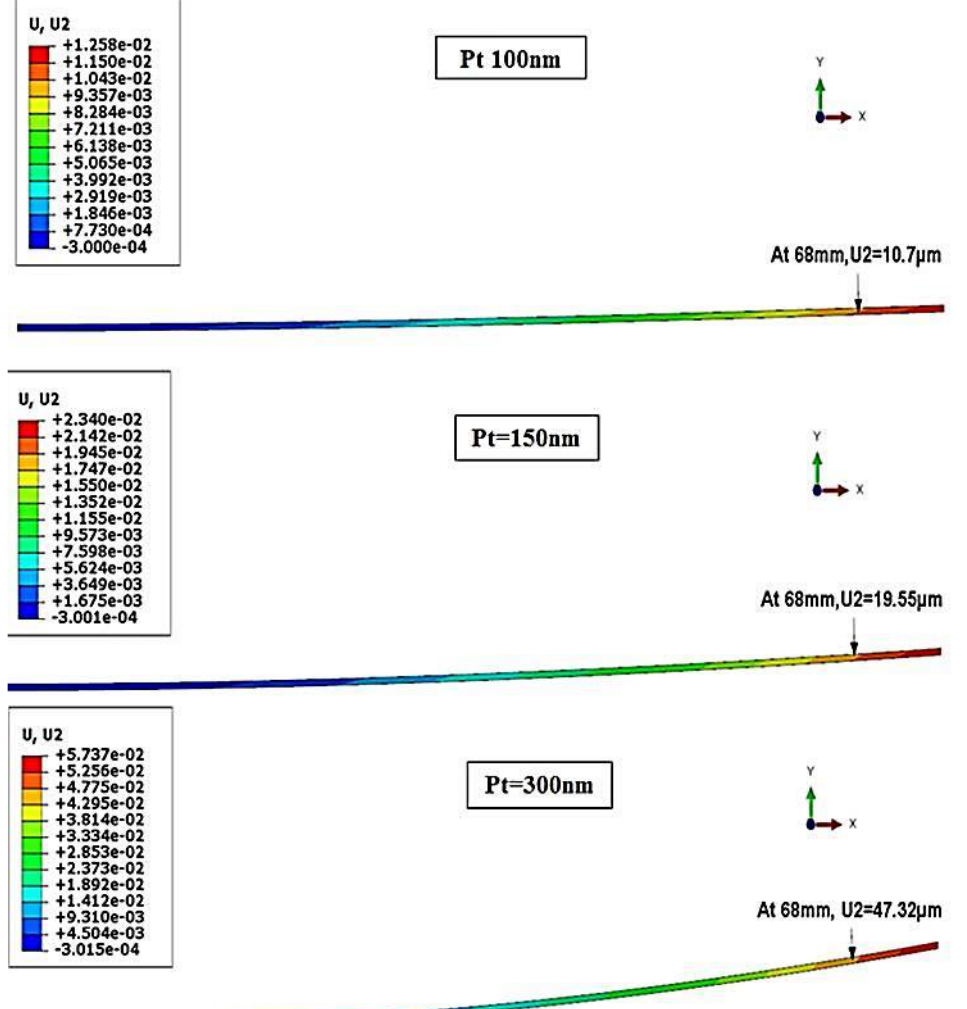
Figure 8. Warpage of the homogenized stack.